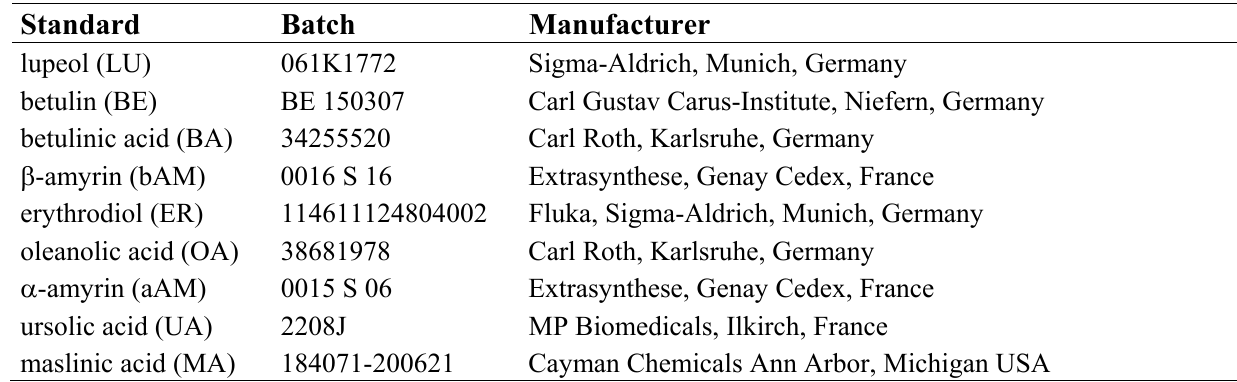
Table 5. Triterpene